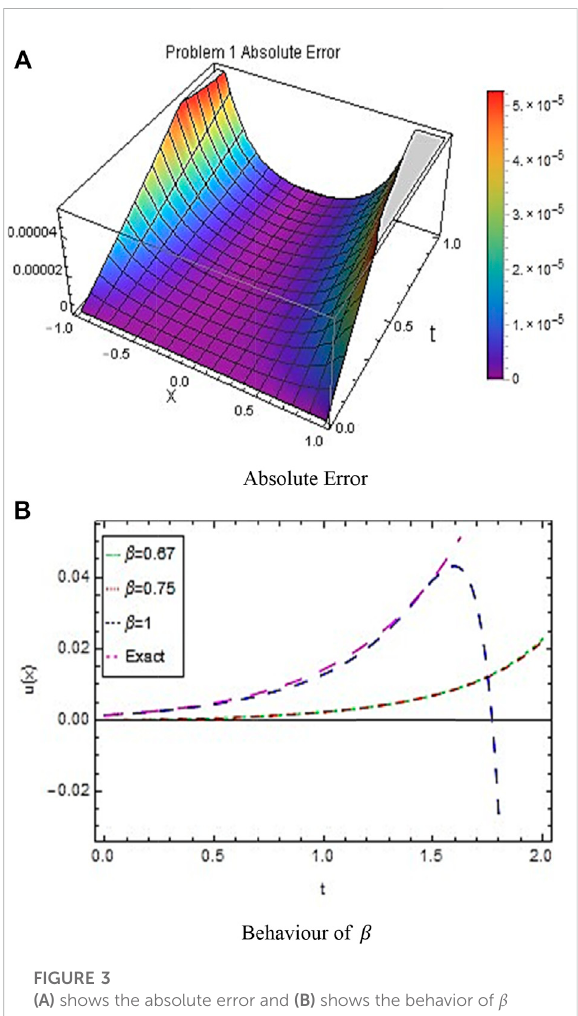
FIGURE 3 (A) shows the absolute error and (B) shows the behavior of β on the solution of the NTIM for diverse amounts of β when x (cid:2) y (cid:2) 0 . 1 , λ (cid:2) 0 . 001 for Example